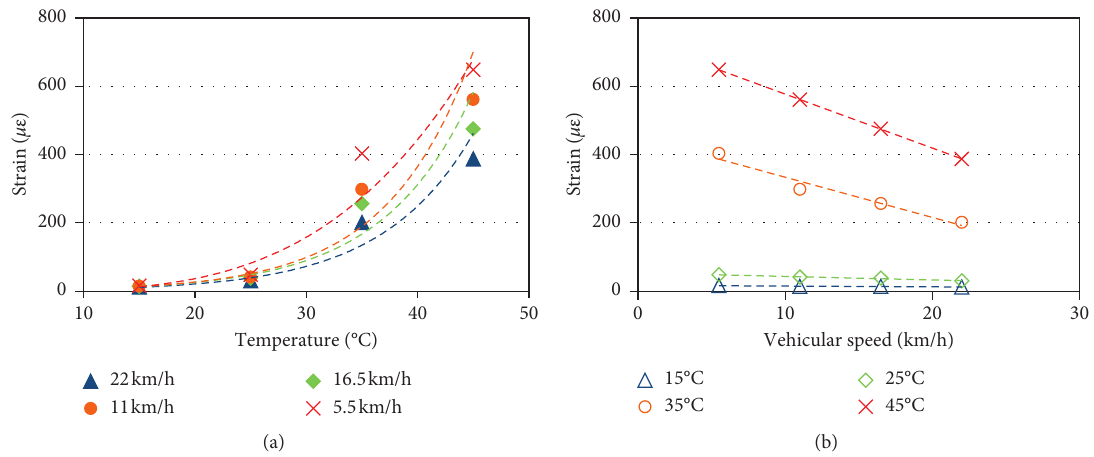
Figure 8: The exemplary varying trend of strain values with (a) temperatures and (b) vehicular speeds.